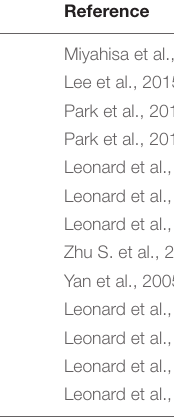
TABLE 3 | List of heterologous microbial hosts for biosynthesis of flavanones and flavones in the literature and estimated production titers. Heterologous flavonoid produced